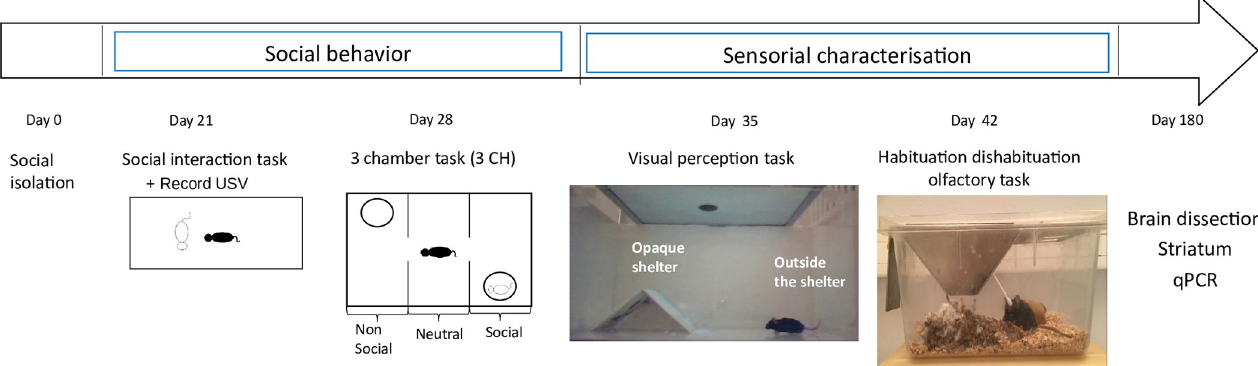
Fig 1. Timeline of experiments. In the social interaction and in the three-chamber tasks, the black mouse represents the Host mouse and the white mouse represents the Visitor mouse.